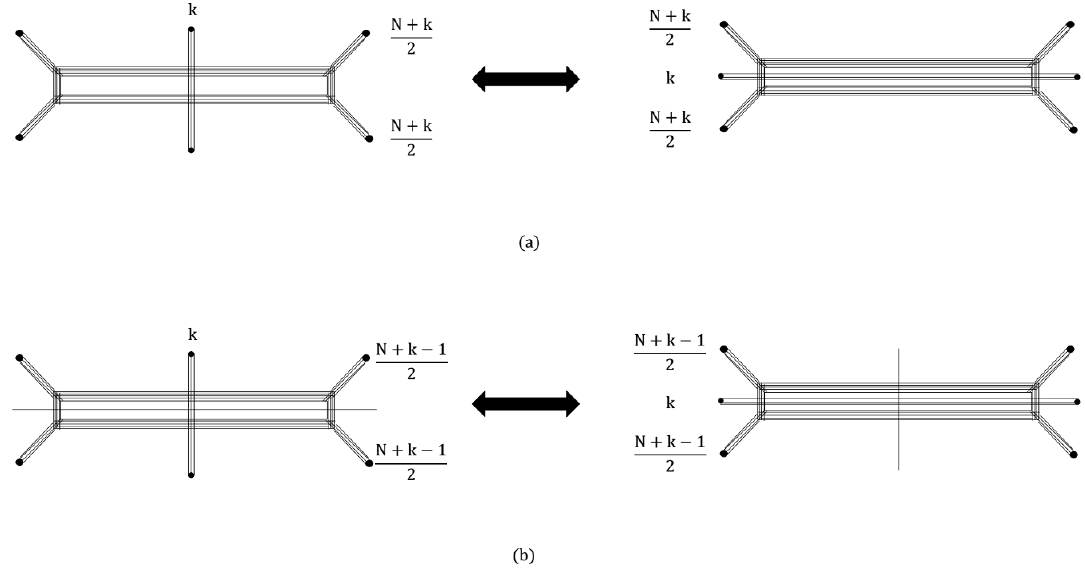
Figure 11 . Two dualities expected from the 5 d construction. (a) is for the case when N + k is even and (b) is when it is odd. The (cid:12)gure on the left reduces to a 4 d gauging of the SCFT expected from the Stiefel-Whitney compacti(cid:12)cation of the 6 d SCFTs discussed in section 3.2.1. The (cid:12)gure on the right is the same con(cid:12)guration, after an S-duality and continuation past in(cid:12)nite coupling. It describes a gauging of a 4 d SCFT that can be described in class S. This manipulation should reduce to a duality in 4 d